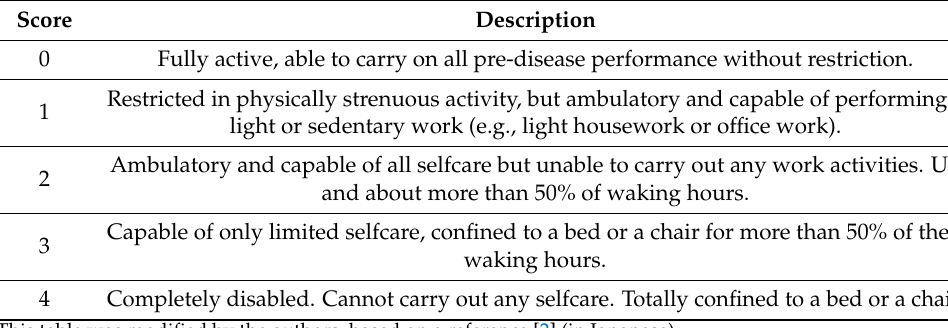
Table 1. Performance Status